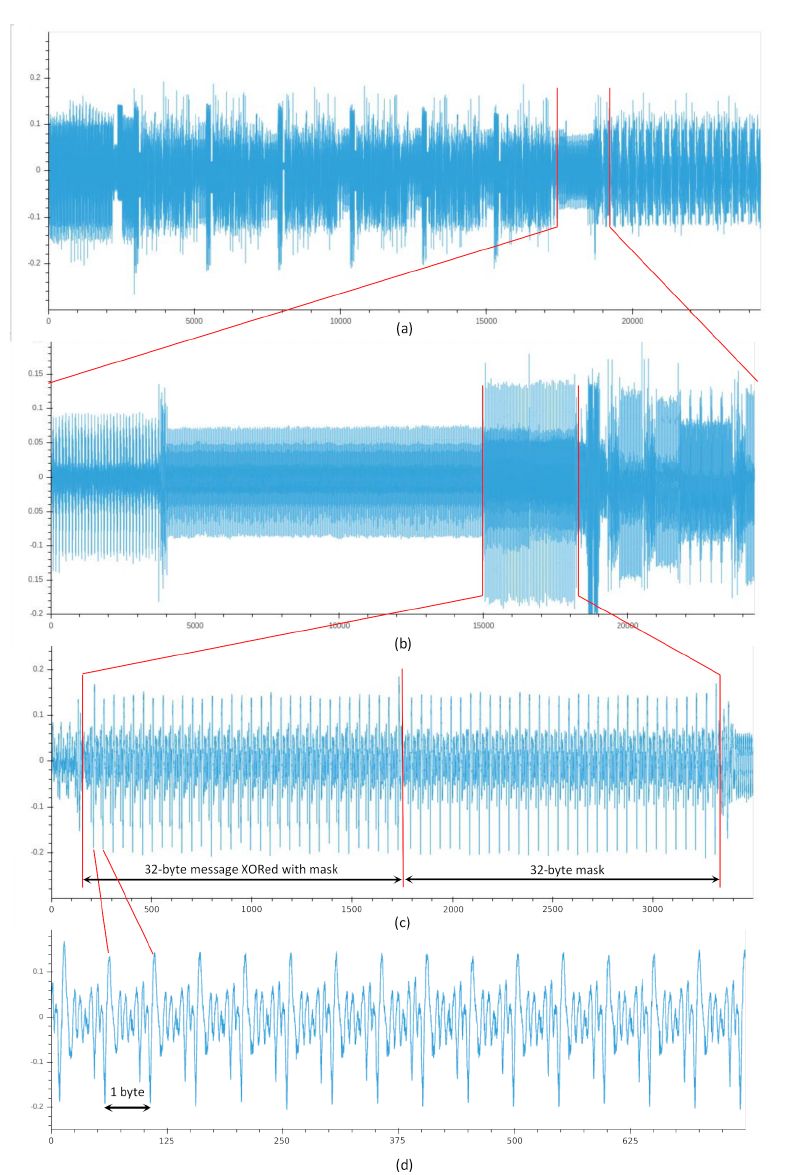
Figure 5: (a) The initial part of Saber.KEM.Decaps() sampled with decimation 15; (b) An interval containing poly_A2A(v1,v2) , POL2MSG(v1,m1) and POL2MSG(v2,m2) ; (c) Two POL2MSG() shares; (d) The first 15 bytes of the first